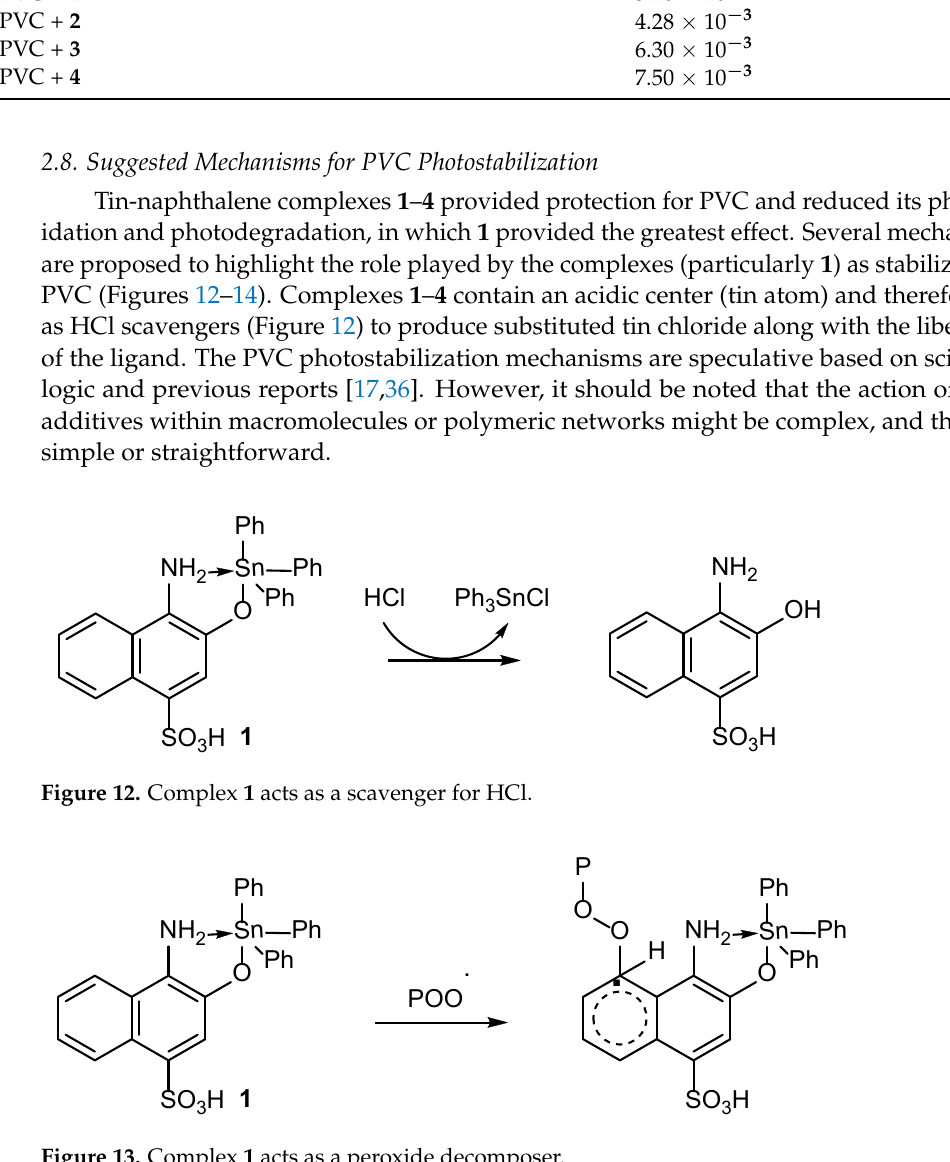
Figure 13. Complex 1 acts as a peroxide decomposer.